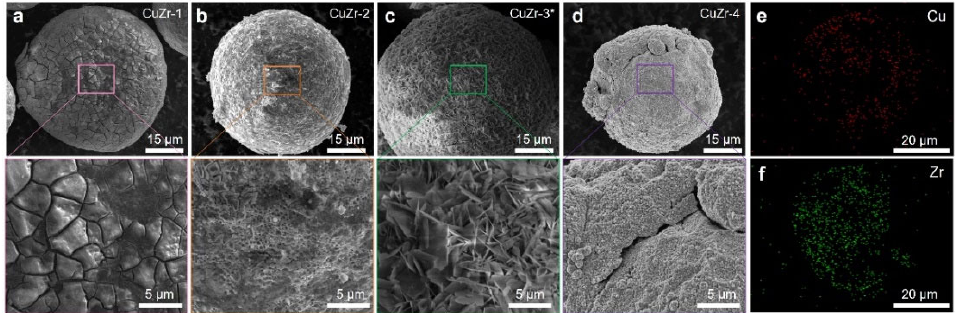
Figure 1. SEM images of the CuZr samples ( a ) CuZr − 1; ( b ) CuZr − 2; ( c ) CuZr − 3*; and ( d ) CuZr − 4. The EDS patterns of the CuZr − 3* sample: ( e ) Cu and ( f )